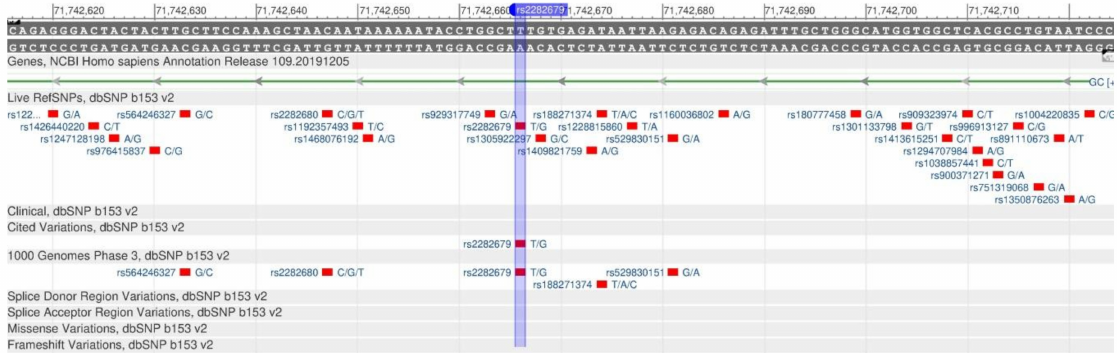
Figure 23. A portion of the GC gene (located on the short (p) arm of chromosome 4) containing the oligonucleotide polymorphism